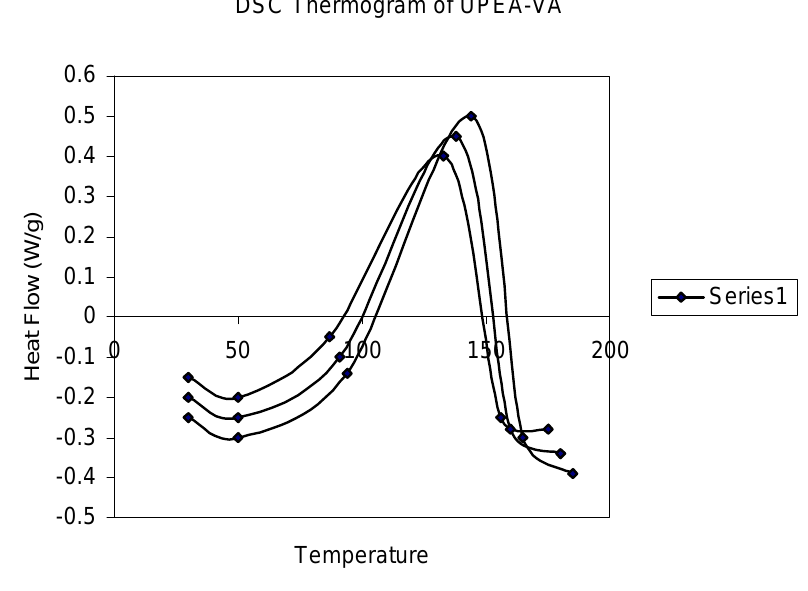
DSC Thermogram of